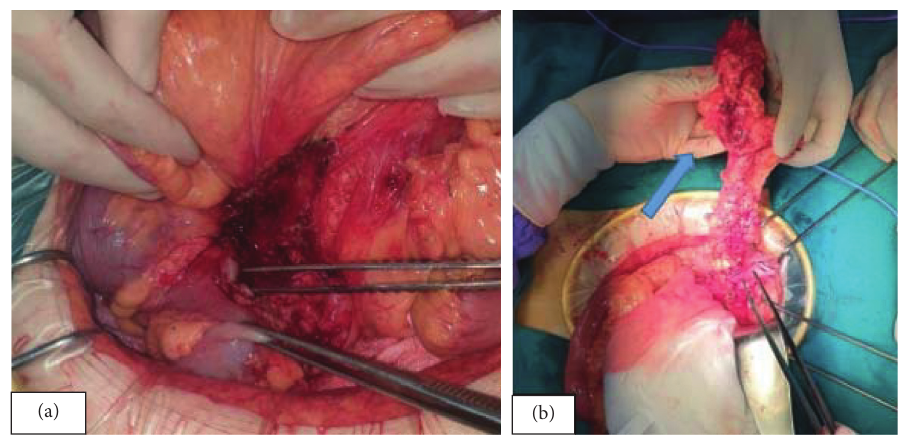
Figure 4: Intraoperative results (a, b); arrow in (b): injured sigmoid